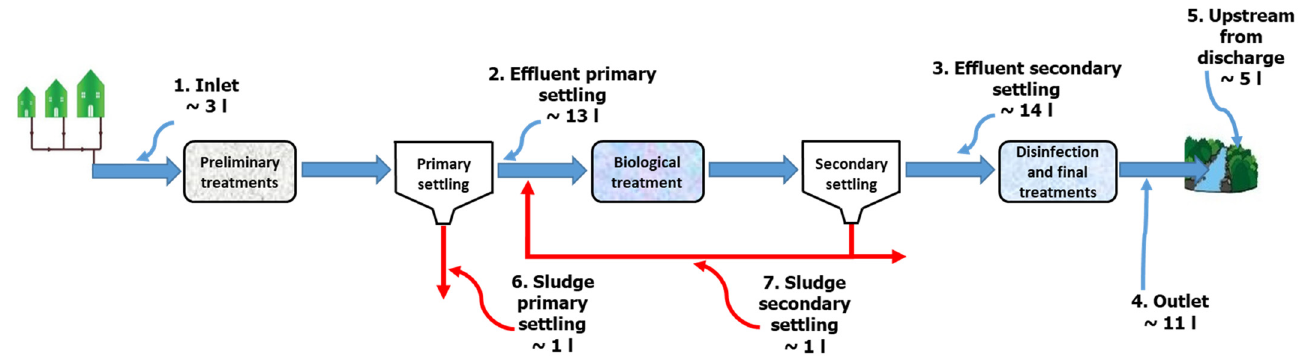
Figure 2. Schematic representation of the types and volumes of samples collected from the WWTP and the river upstream the plant.